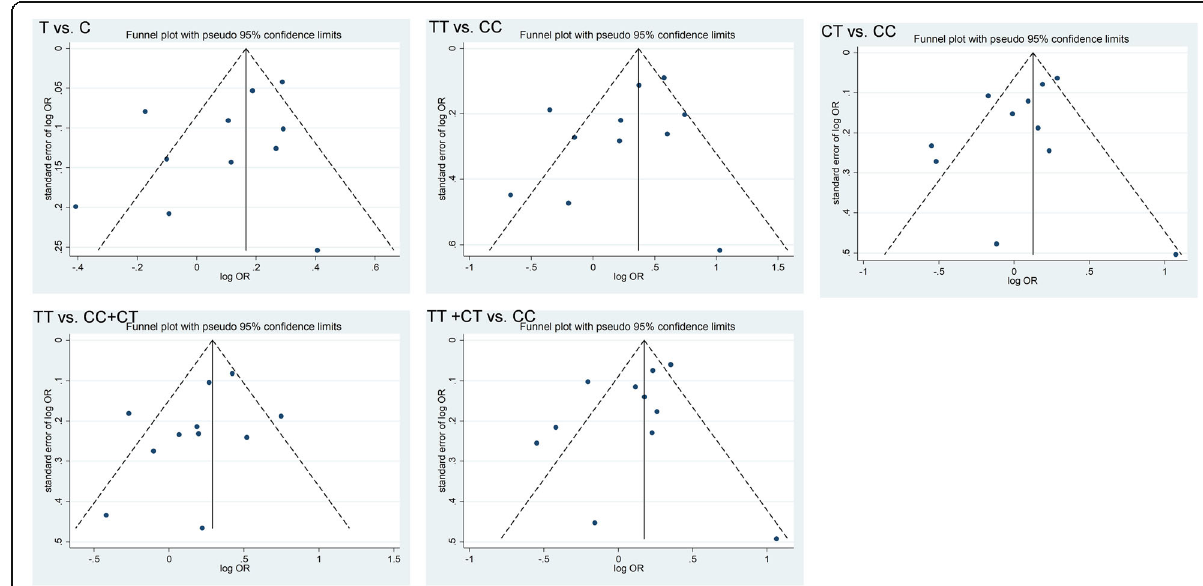
Fig. 3 Funnel plots of Begg ’ s test to evaluate publication bias in the included